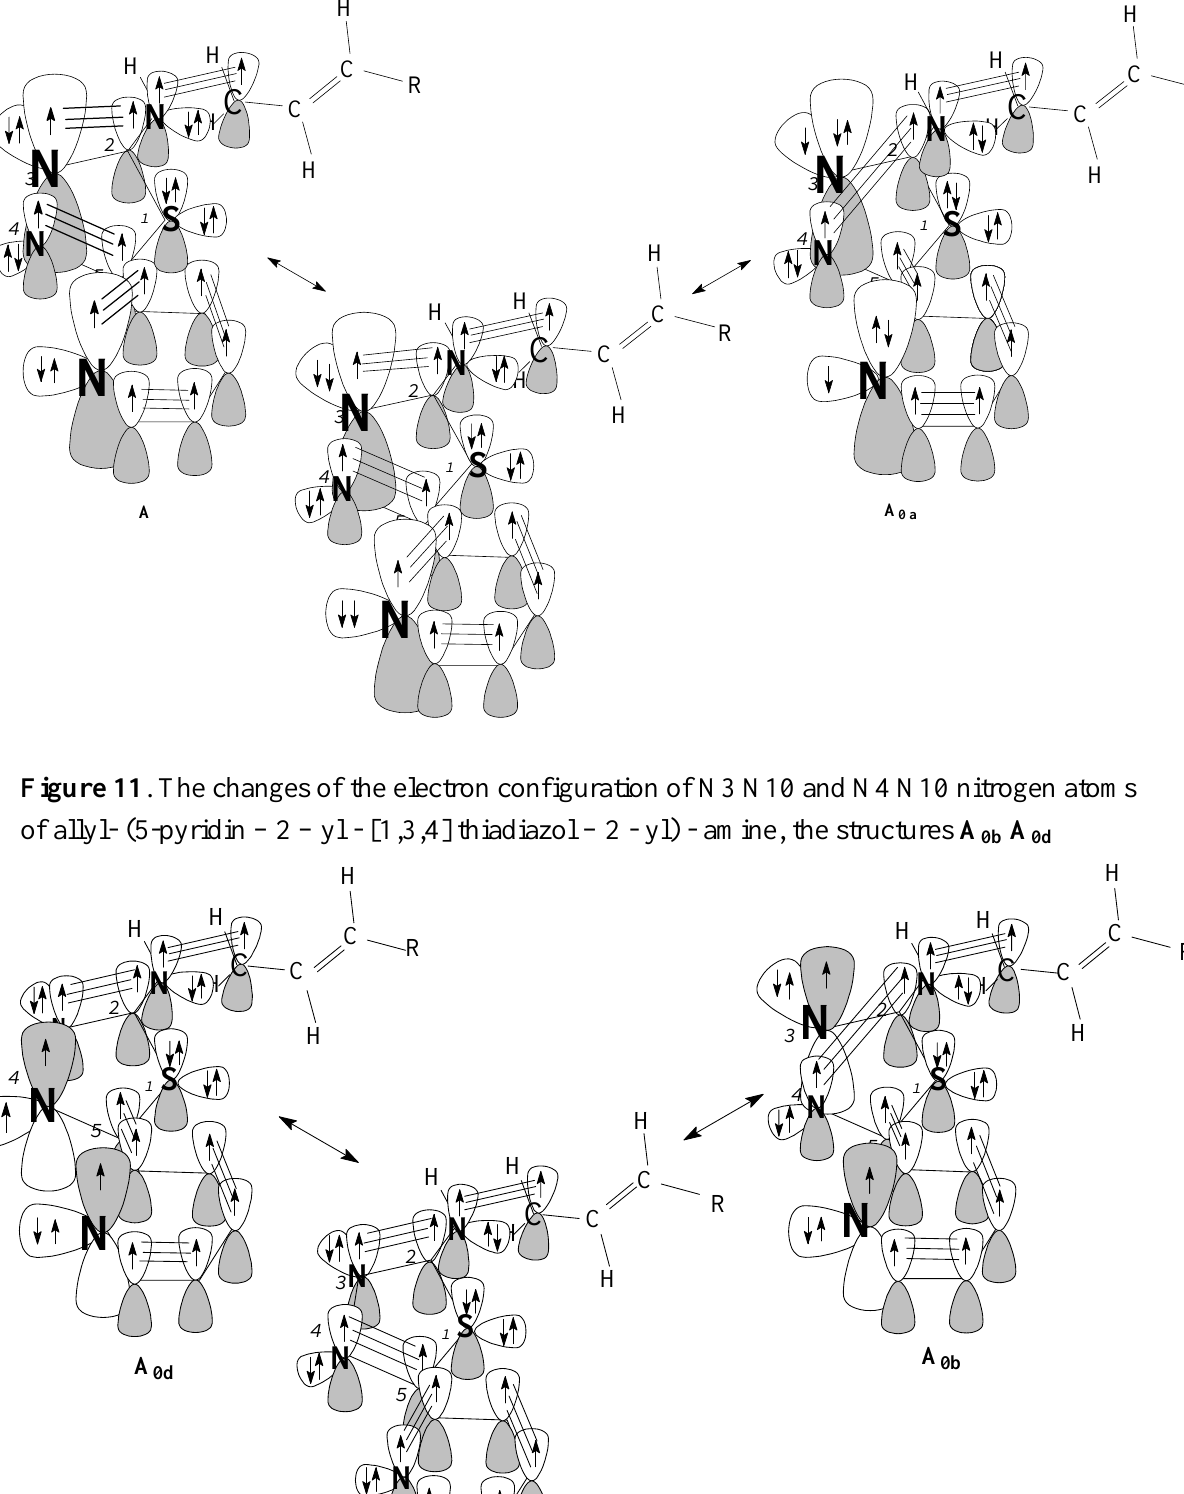
Figure 10 . The changes of the electron configuration of N3 N10 nitrogen atoms of allyl- (5- pyridin – 2 – yl - [1,3,4] thiadiazol-2-yl)-amine, the structure A